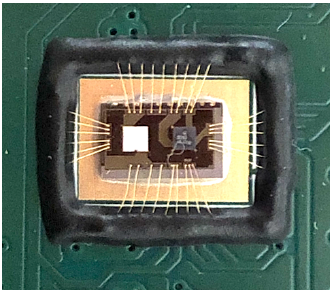
Figure 10. LED driver IC wire-bonded to the PCB following FC bonding process.